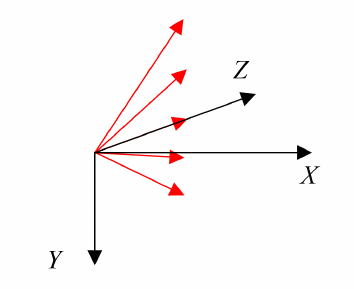
Figure 3. LiDAR coordinate